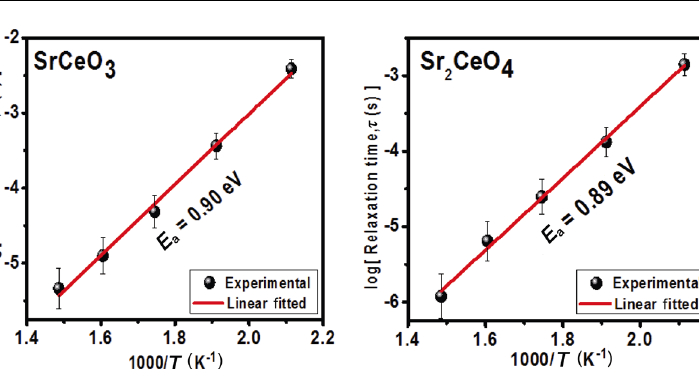
Fig. 9 Variation of logarithm of relaxation time of grain ( τ g ) with inverse of